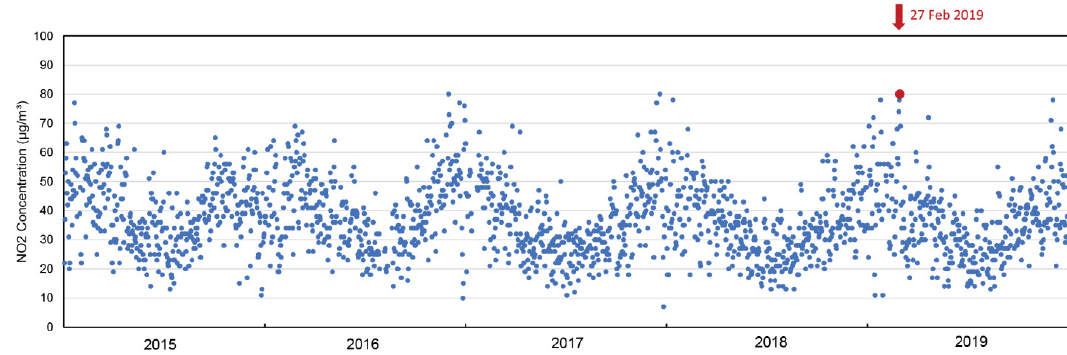
Figure 2. Average daily NO 2 concentration in Manchester [25].